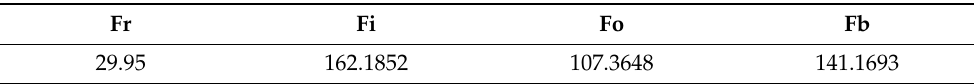
Table 9. Fault characteristic frequency (unit: